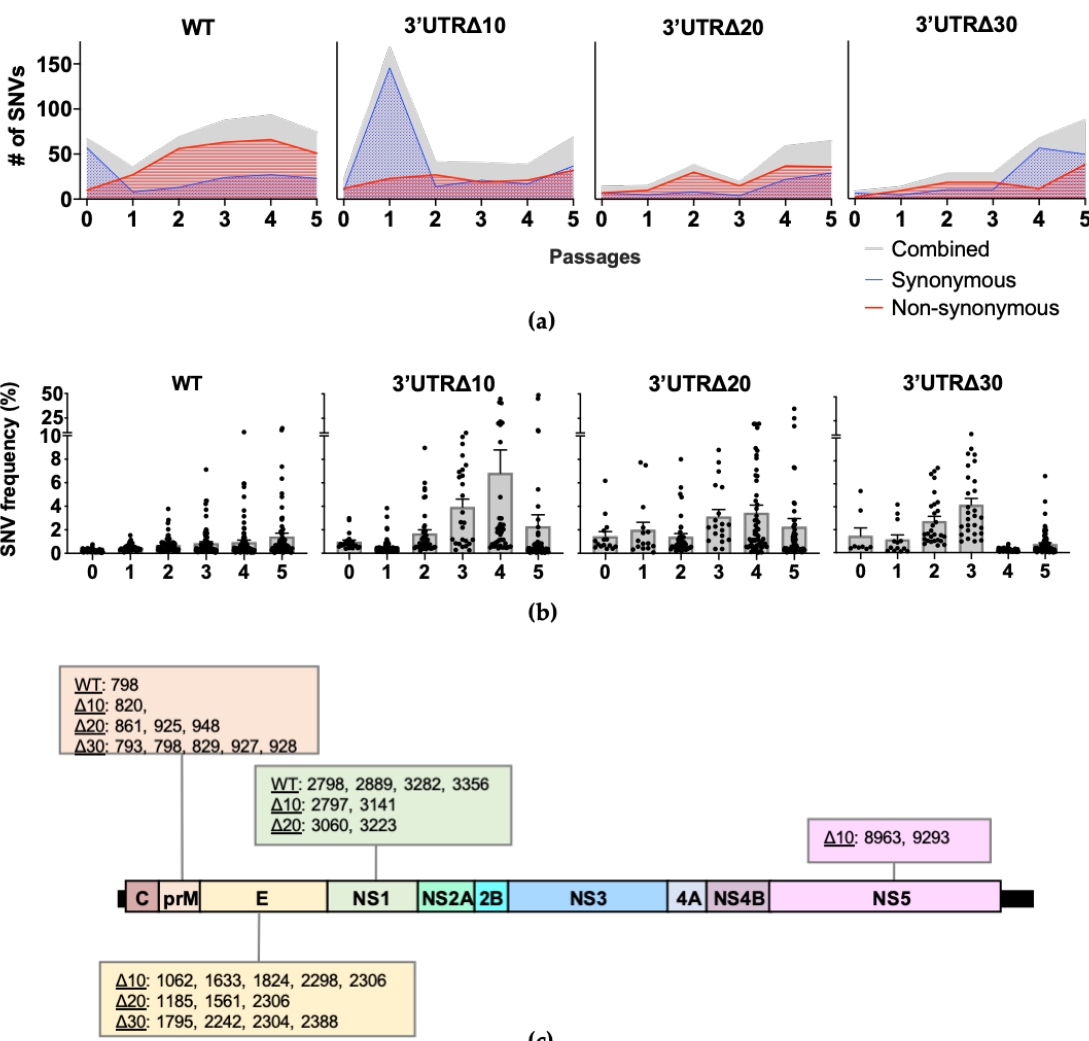
Figure 2. Single nucleotide variant (SNV) analysis of each virus sequence. ( a ) The total number of SNVs per passage is depicted in gray; synonymous and non-synonymous SNVs are shown in blue with dotted fill and red with horizontal line fill, respectively. Cuto ff for strand bias α = 0.05. ( b ) The mean frequency ( +/ − standard error of the mean) of SNVs is shown across passages. Each symbol represents a SNV. ( c ) SNVs present in multiple passages with frequencies reaching at least 5% are shown according to the genome position.